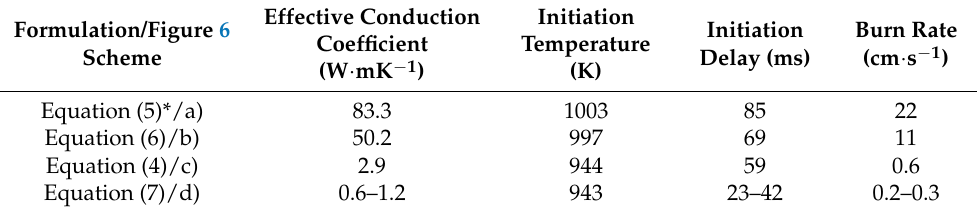
Table 2. Calculated initiation and combustion performances for a thermite system of 80 nm Al: 99 nm CuO ( ξ = 1.0) at 60 %TMD (except for * which is 100 %TMD) considering the different effective conductivity